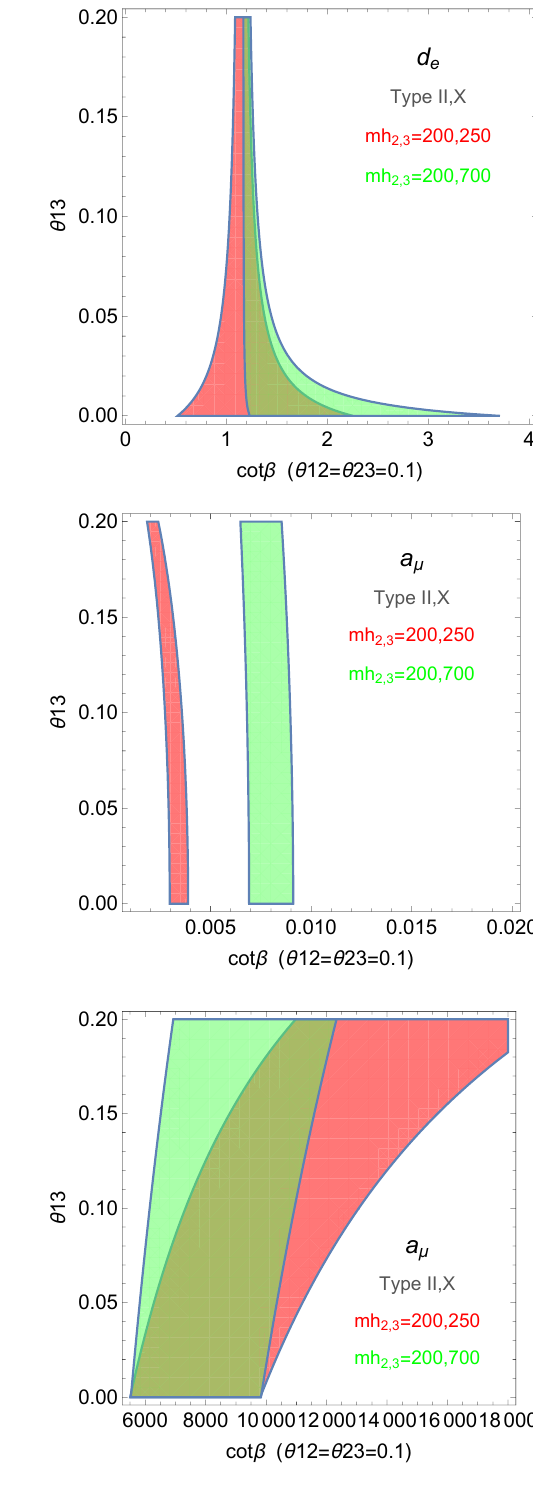
masses (in GeV) and (cid:12)xed values of (cid:18) 12 2 ; 3